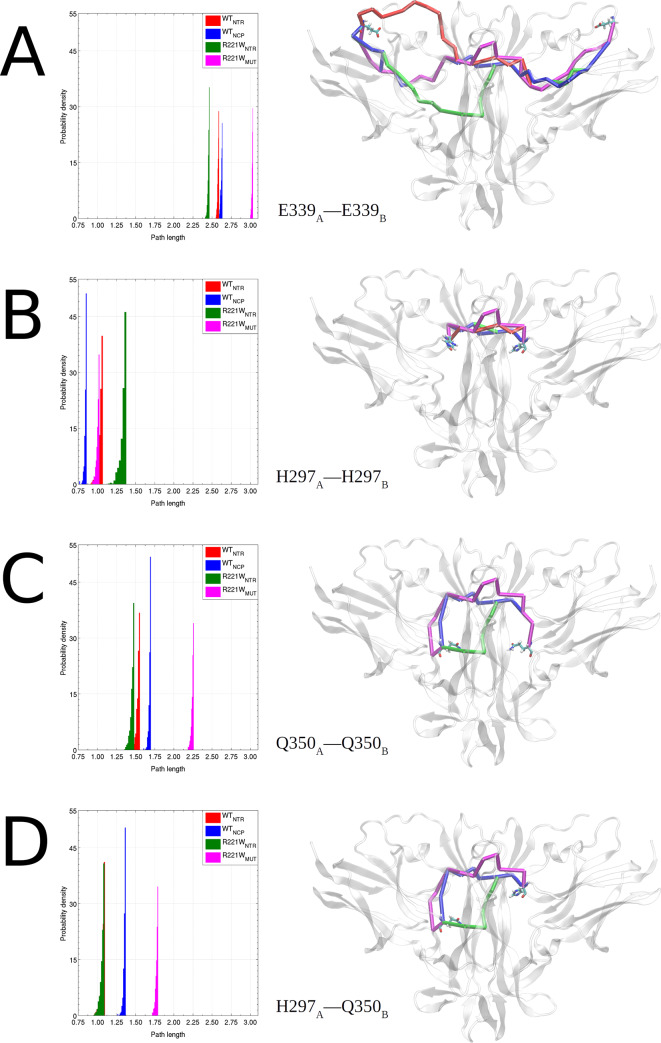
Optimal and suboptimal paths of interface residues.Optimal and suboptimal paths coupling the TrkA residues (A) E339A–E339B, (B) H297A–H297B, (C) Q350A–Q350B and (D) H297A–Q350B. QNTR motions can couple the two binding sites, while QNCP motions efficiently connect TrkA chains only via specific patch. The QMUT suboptimal paths are longer in almost all cases, which indicates its contribution to communication impairment. The shortest path is shown in the representation of the structure. Source and sink residues are presented as licorice. The histograms show the length distribution of the 500 paths calculated for each pair of residues.